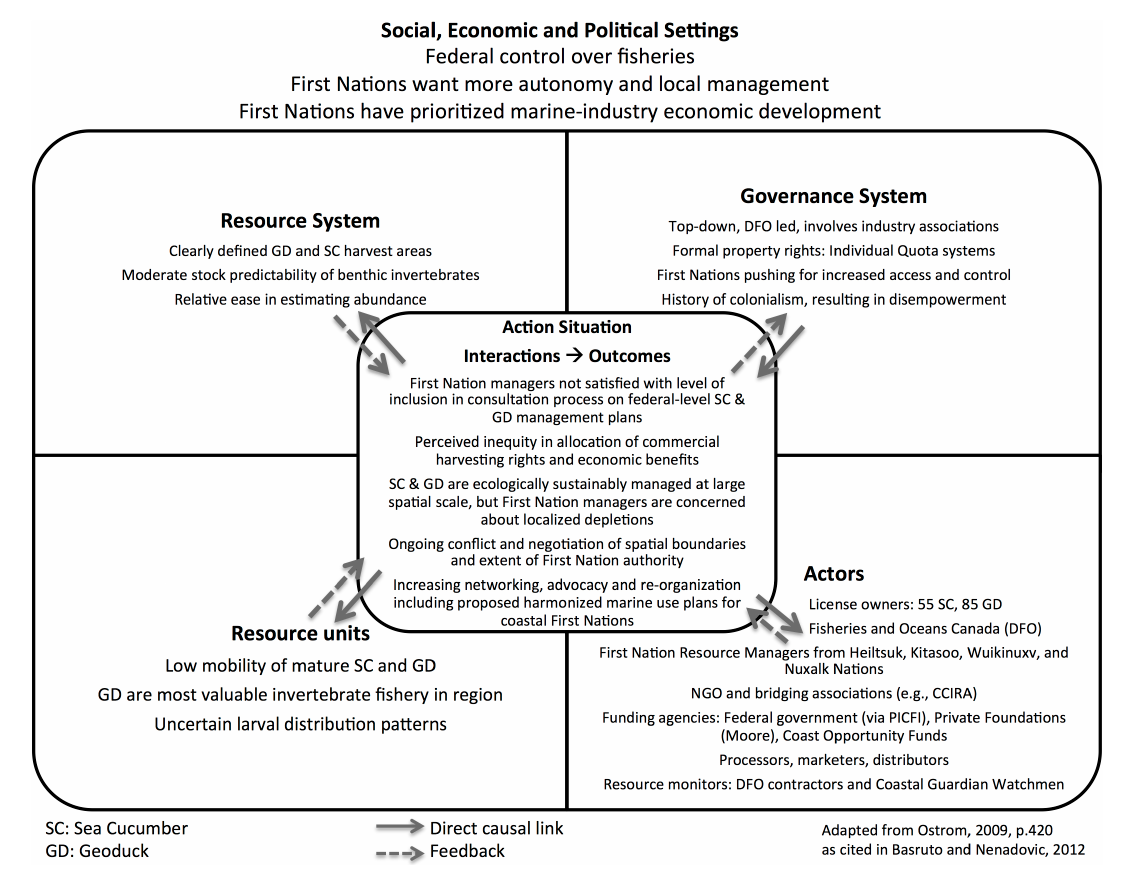
Fig. 2. Central coast First Nations sea cucumber (SC) and geoduck (GD) social-ecological system. Adapted from Ostrom